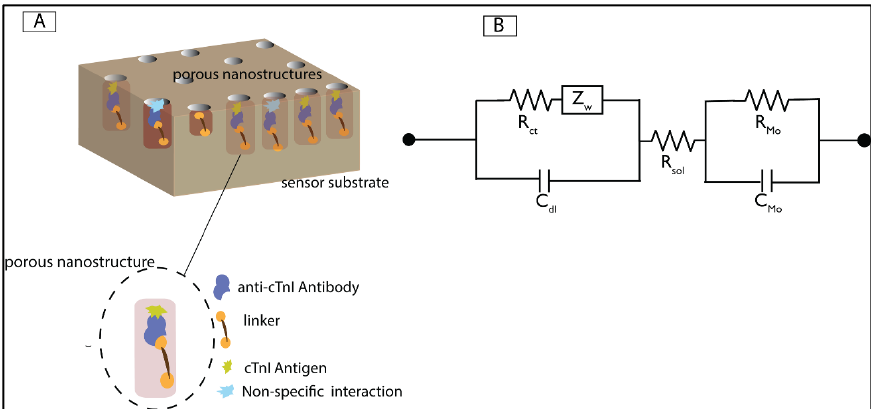
Figure 2. Biosensor design and electrical circuit model. ( A ) Schematic representation of immunoassay of the Mo biosensor indicating the deposition of Mo on the pores of the membrane. The enlarged segment indicates the building of immunoassay on the pores; ( B ) Schematic representation of the equivalent circuit of the Mo biosensor. C dl represents the double layer capacitance dominated by biomolecular binding. R sol represents the resistance contributed by the solution, Zw represents the Warburg Impedance and R ct represents the charge transfer resistance, R Mo represents the resistance at the Mo electrode, C Mo represents the interfacial capacitance at the Mo electrode surface.